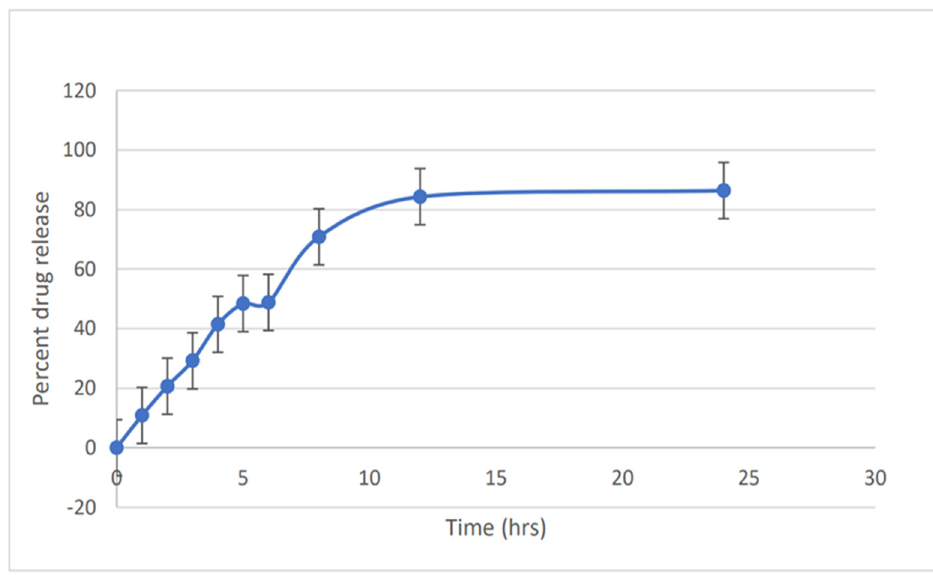
Figure 5. Percentage release study of Hsp-PAMAM.